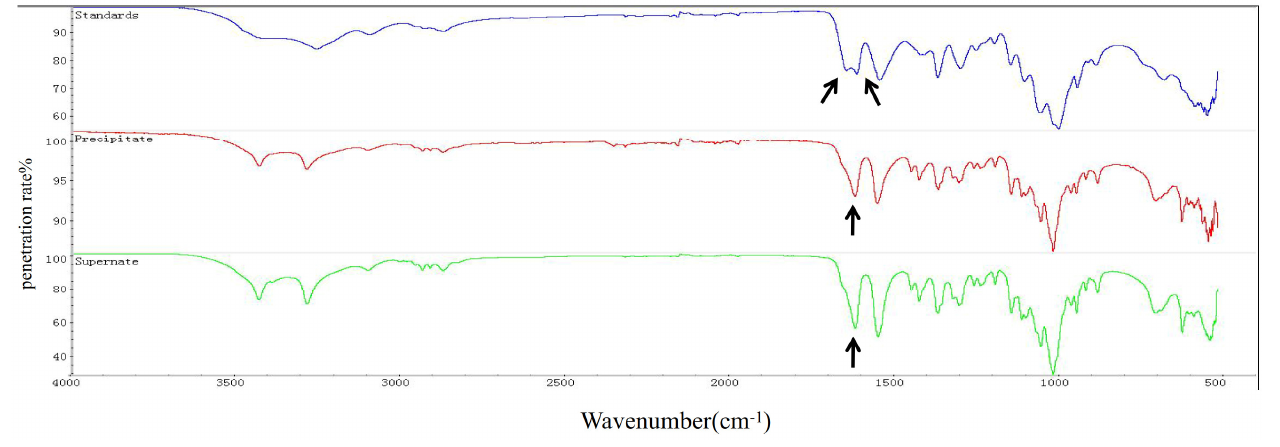
Figure 1. FTIR spectra of chitin (0–4000 cm −1 ). α-Chitin standard forms a double peak at 1620 cm −1 and 1652 cm −1 (the blue curve); the chitin extracted from the precipitation of T. weissflogii had a single peak at 1625 cm −1 (the red curve); the chitin extracted from the supernatant of T. weissflogii had a single peak at 1625 cm −1 (the green curve). The arrow indicates the location of the characteristic peaks.